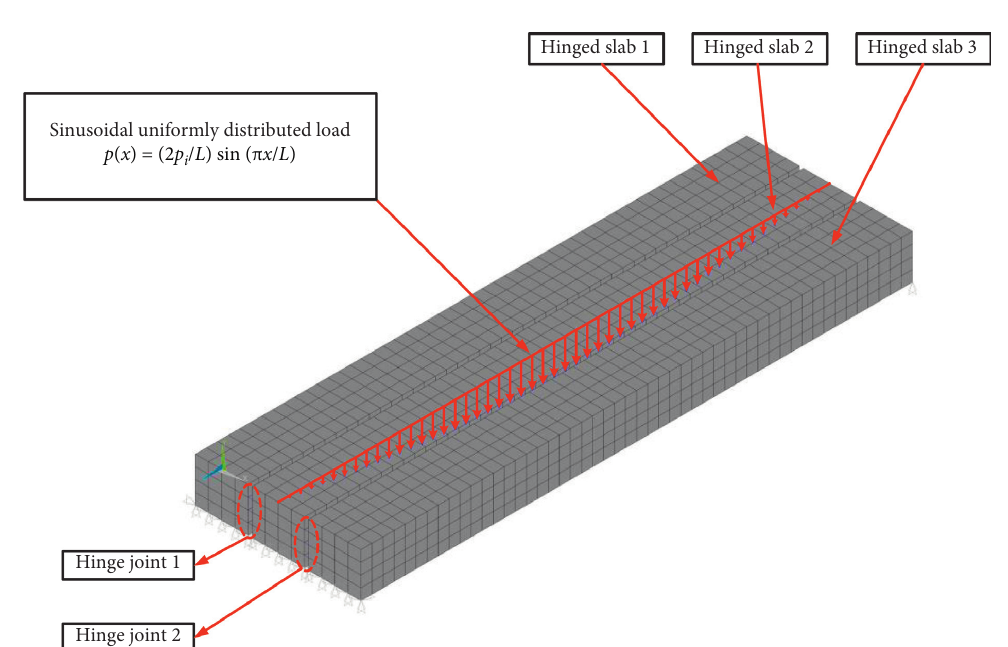
Figure 6: Finite element analysis model